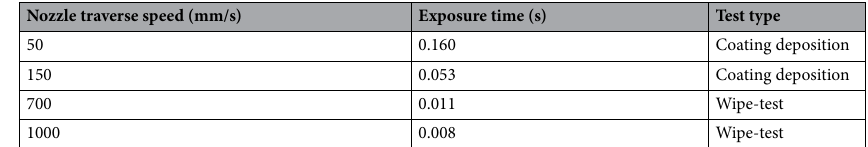
Table 3. Exposure time as a function of nozzle speed for typical coating deposition and single-particle impact tests with a flow spot diameter of 8 mm.